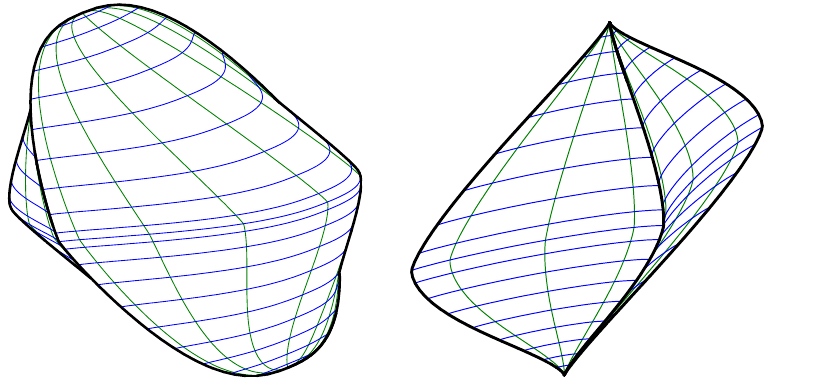
Figure 11. Different entries of matrix A and different exponents p k